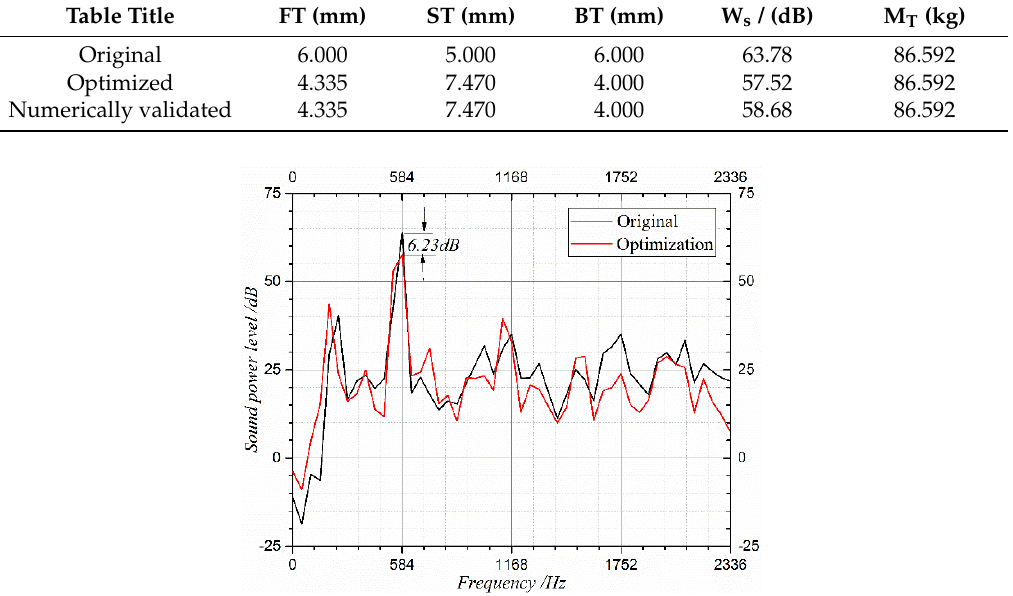
( c ) Figure 28. The distribution of vibrational sound radiation of original volute at the fundamental frequency. ( a ) The whole volute body; ( b ) XY section; ( c ) ZY section.